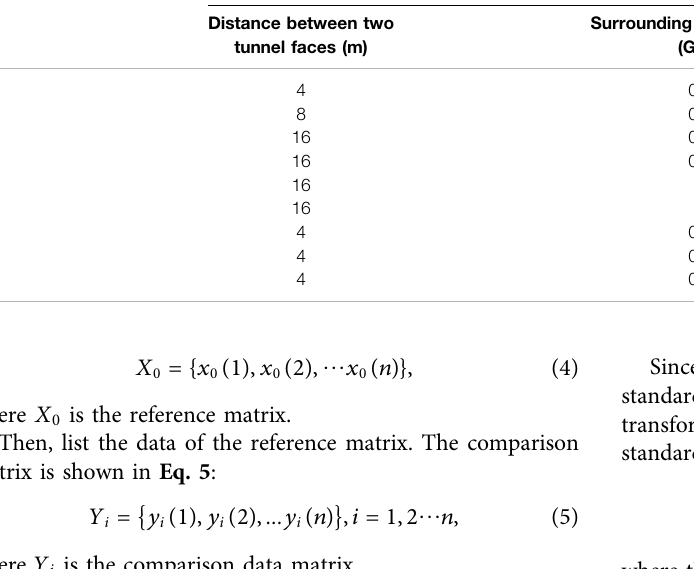
TABLE 3 | Different construction conditions of fi nite element simulation. Case Variable Distance between two tunnel faces